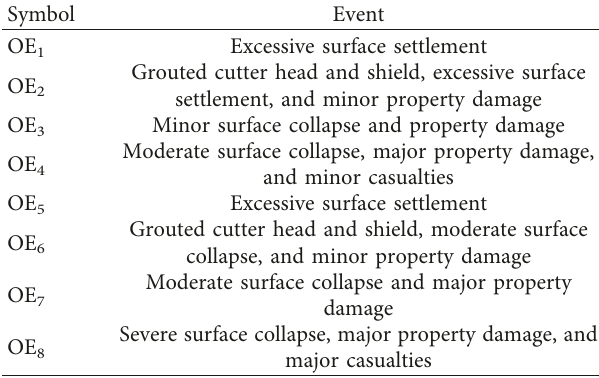
Table 10: Analysis of event occurrence.